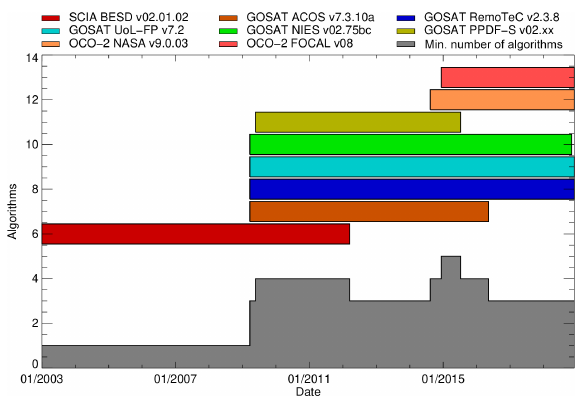
Figure 3. Individual satellite sensor XCO 2 data products contribut- ing to the merged XCO 2 data products (see Table 1 for details). The required minimum number of contributing products is shown by the grey